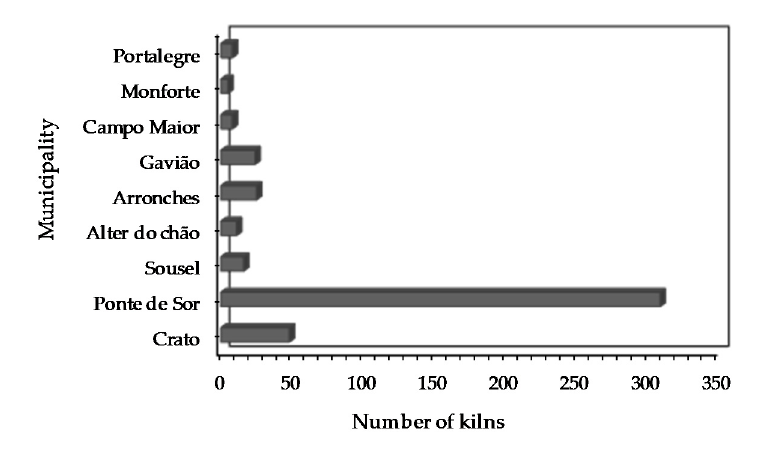
Figure 1. Number of charcoal kilns by municipality.